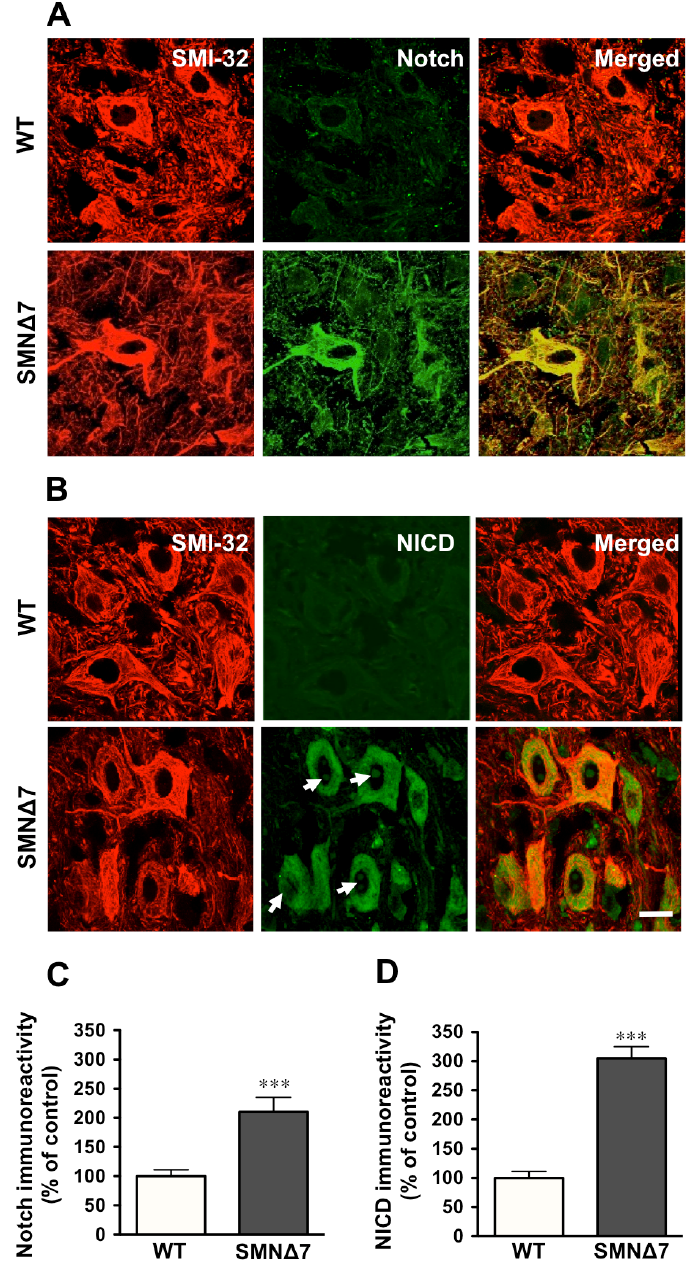
Figure 3. Notch signaling is activated in spinal muscular atrophy (SMA) spinal cord motoneurons. ( A , B ) Representative images of SMI-32 and Notch ( A ) or SMI-32 and NICD ( B ) immunohistochemistry in the ventral horn of lumbar spinal cord of P11 wild-type (WT) and SMN Δ 7 mice showing that motoneurons are co-labeled with these antibodies (merge), and display increased Notch ( A ) or NICD ( B ) expression in SMN Δ 7 mice. Arrows in ( B ) indicate the presence of NICD immunoreactivity in the nucleus of SMN Δ 7 motoneurons. Scale bar = 20 μ m applies to all photographs in ( A ) and ( B ). ( C , D ) Columns represent the percentage of Notch ( C ) or NICD ( D ) immunoreactivities in SMI-32 positive cells (motoneurons) in the lumbar spinal cord of P11 SMN Δ 7 as compared to control (WT) mice and represent the mean ± SEM (error bars) of at least four mice for each group. *** p < 0.001 as compared to age-matched